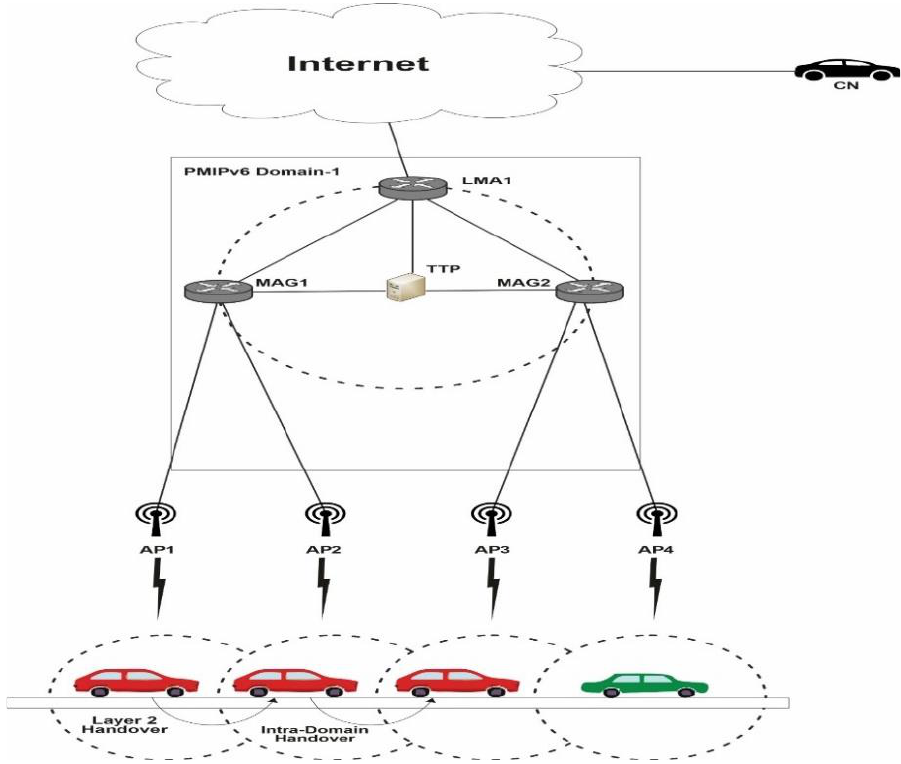
Figure 6. Intra-Domain Handover of Vehicle in PMIPv6 for Cost Analysis.